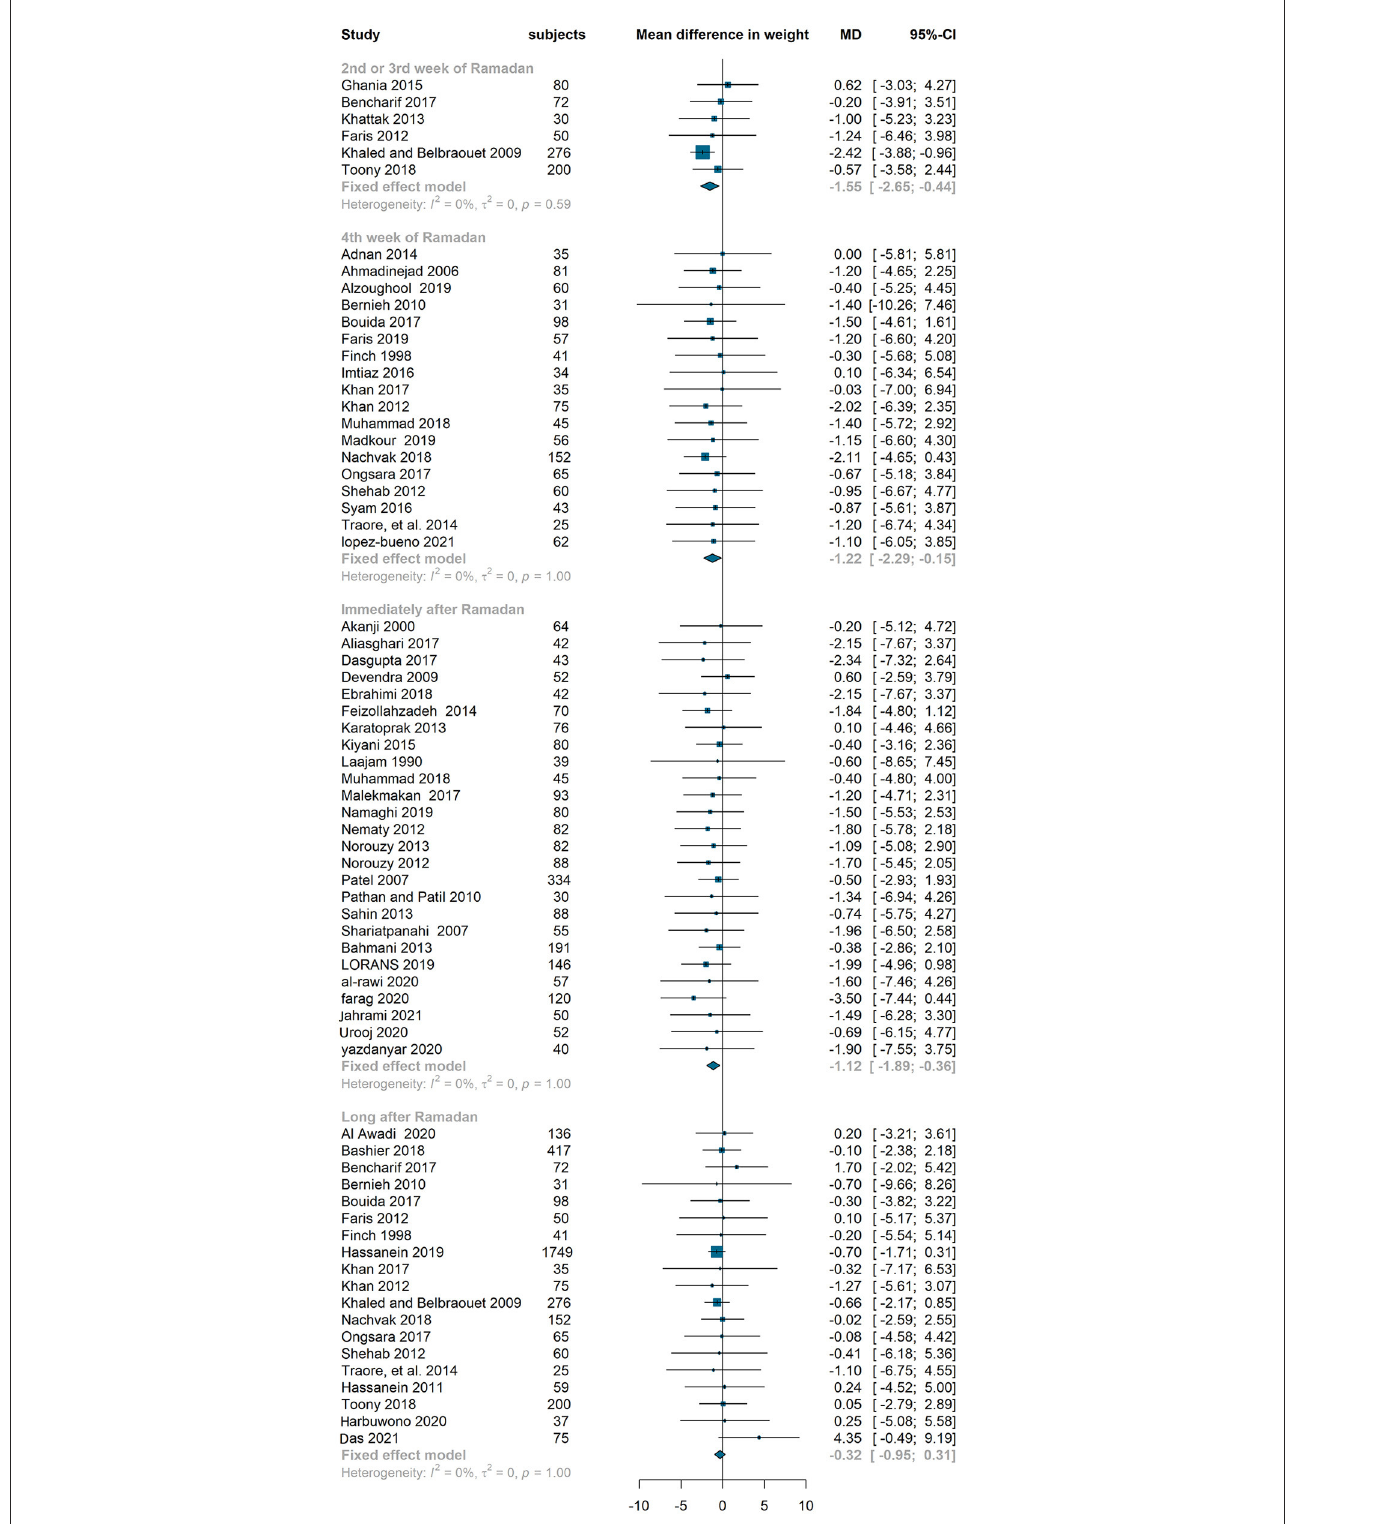
FIGURE4 Fixed effect meta-analysis of RIF effect on weight.